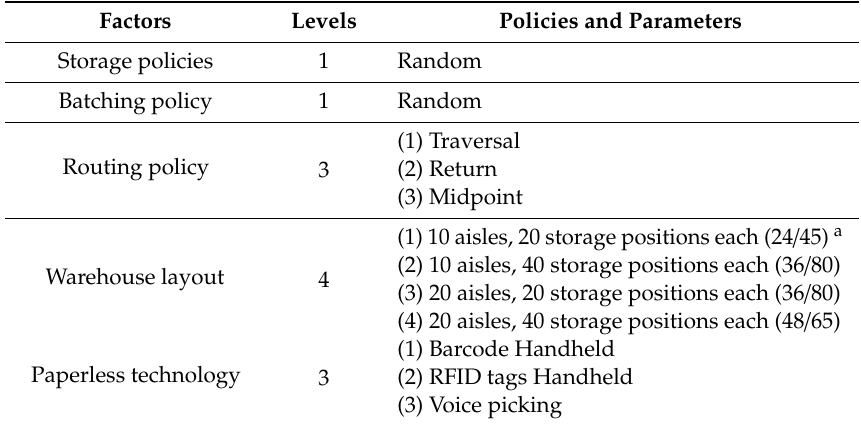
Table 1. Experimental factors and levels.